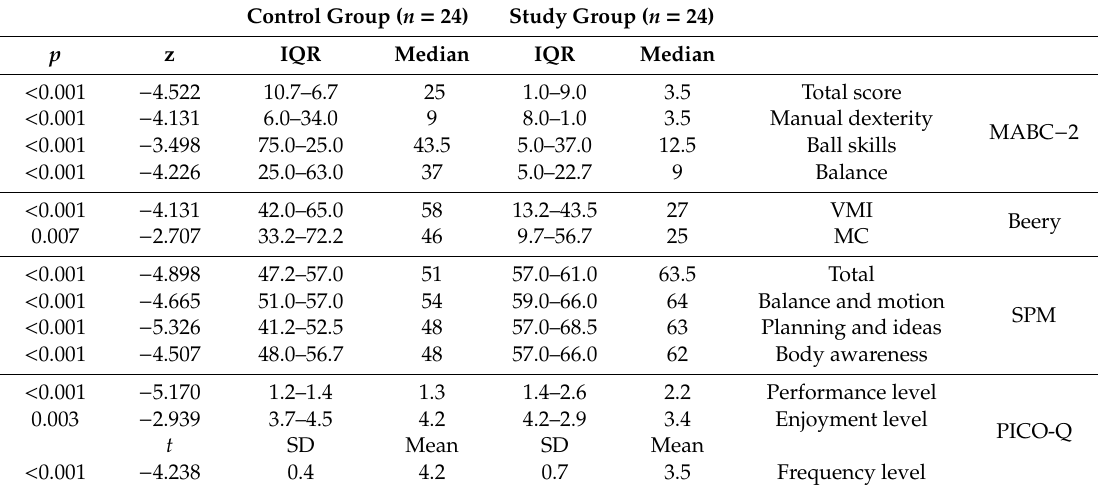
Table 2. Di ff erences between groups in the motor performance scores. Data are presented as either mean and standard deviation (SD) or median and interquartile range (IQR), according to the distribution of the